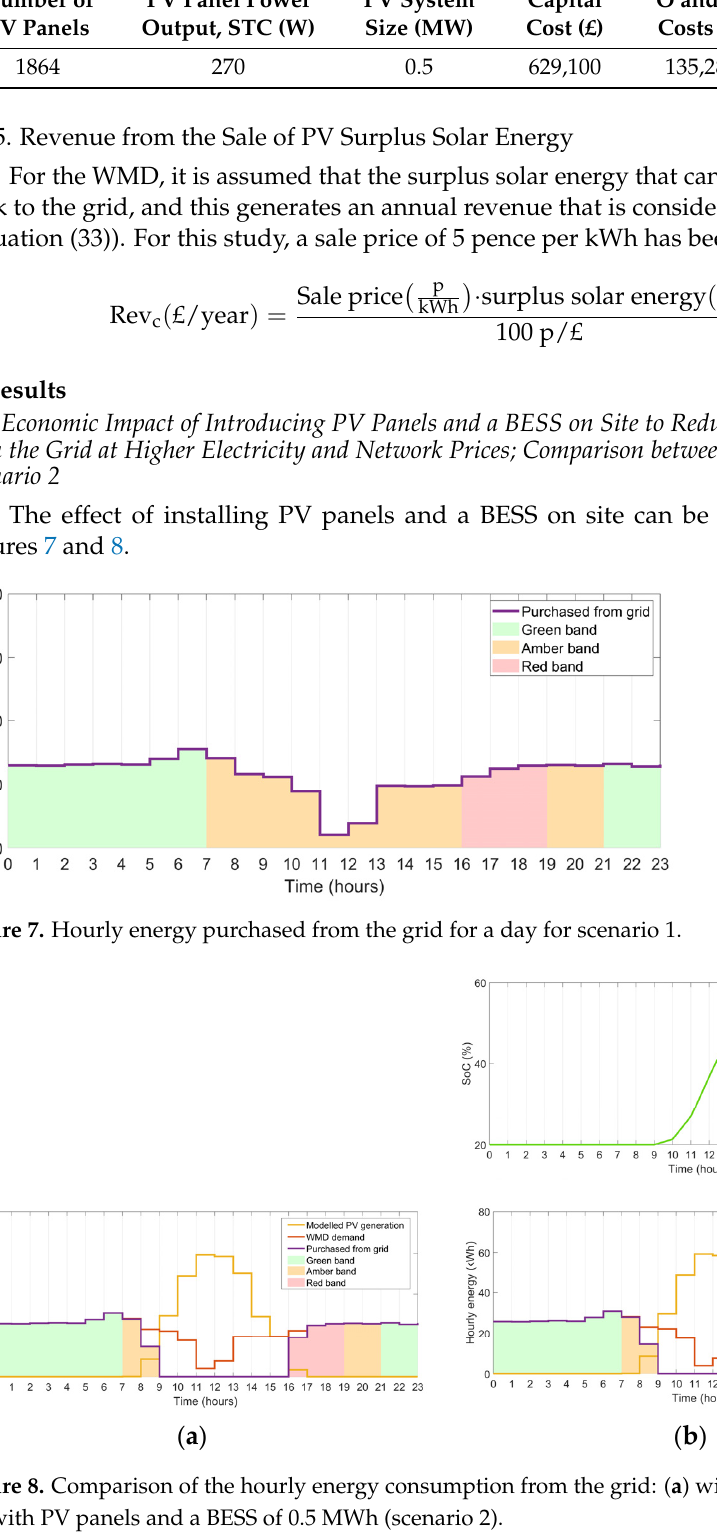
Table 5. Total cost of PV installation for a lifetime of 15 years.